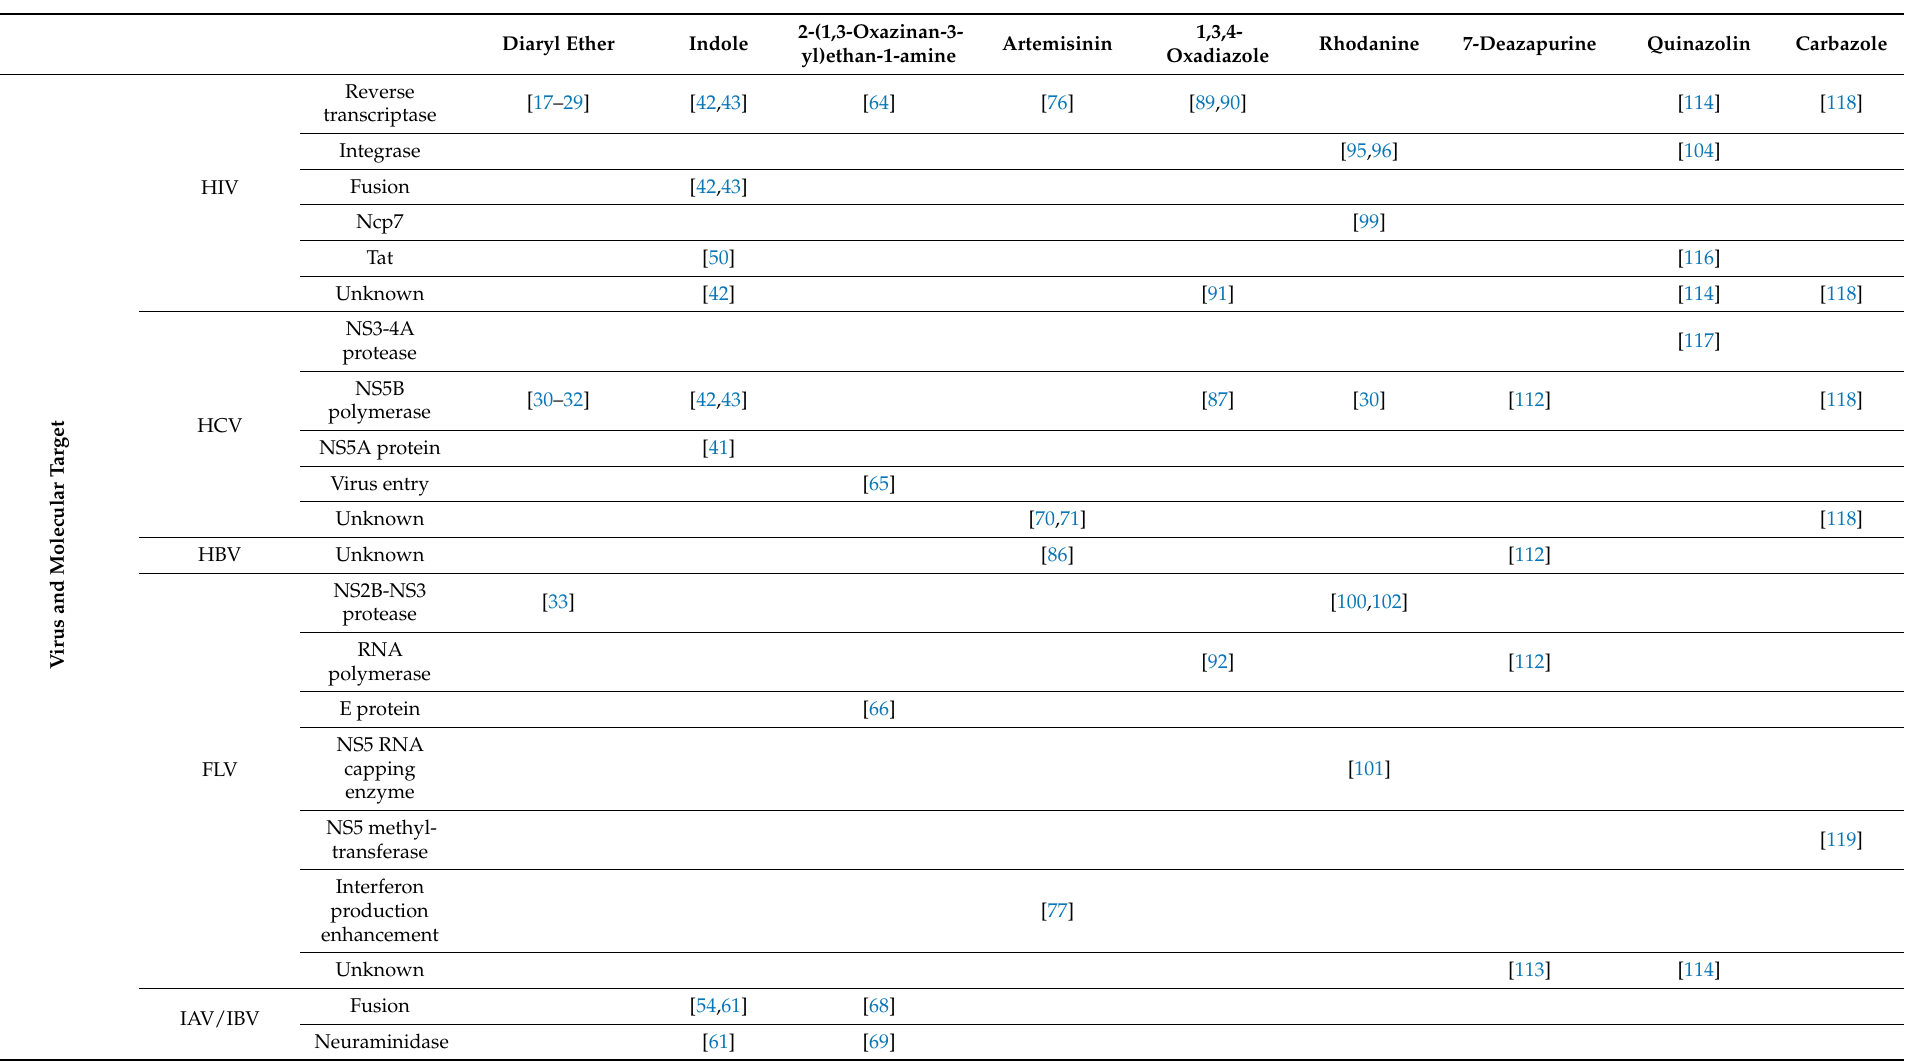
Table 2. Privileged structures present in antiviral